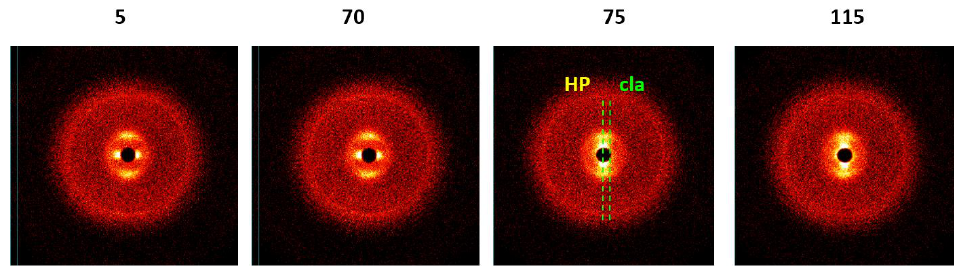
Figure 19. Evolution of X-ray diffractogram during prolong shearing of dispersion at shear rate of 471 s −1 . Numerical values mean shearing time, min. The final result is shown schematically in Figure 20.